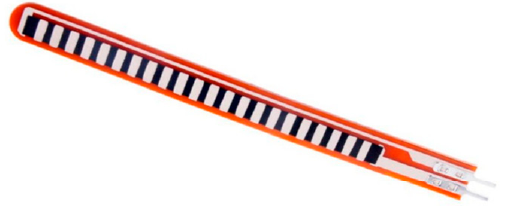
Figure 5. Flex sensor or bend sensor [12,14,26].